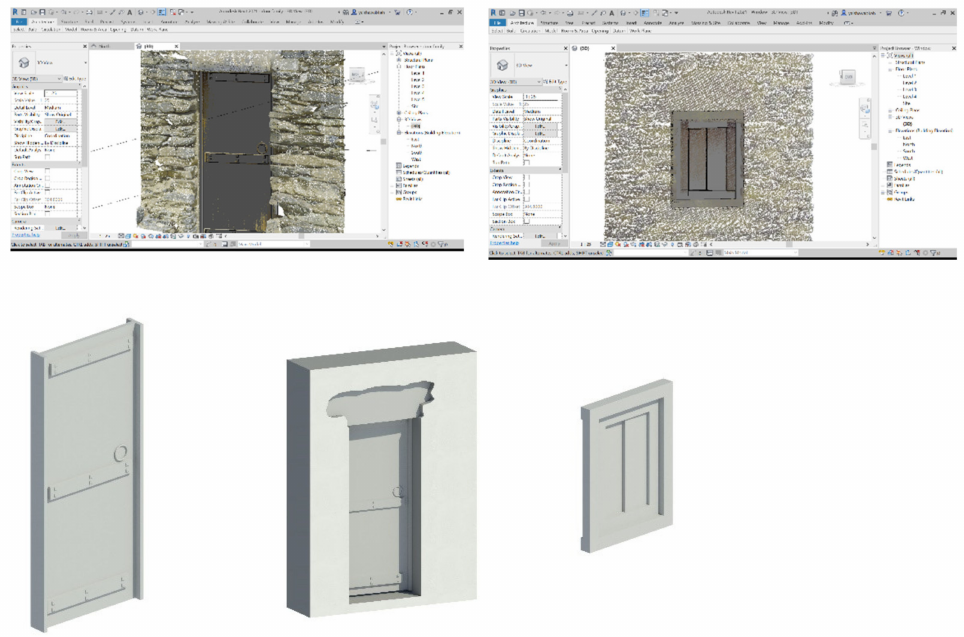
Figure 17. From point clouds to HBIM models (create new families).